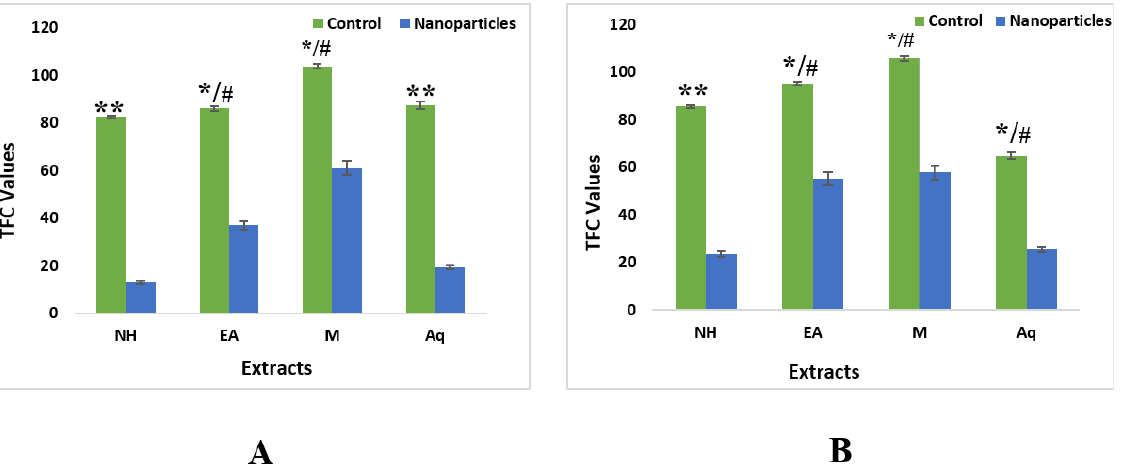
Figure 9. Total flavonoid contents of nanoparticles and control extracts of W. somnifera from ( A ) Leaves ( B ) From Roots. Data are expressed as the mean ± SD. */# p < 0.05, ** p < 0.01.